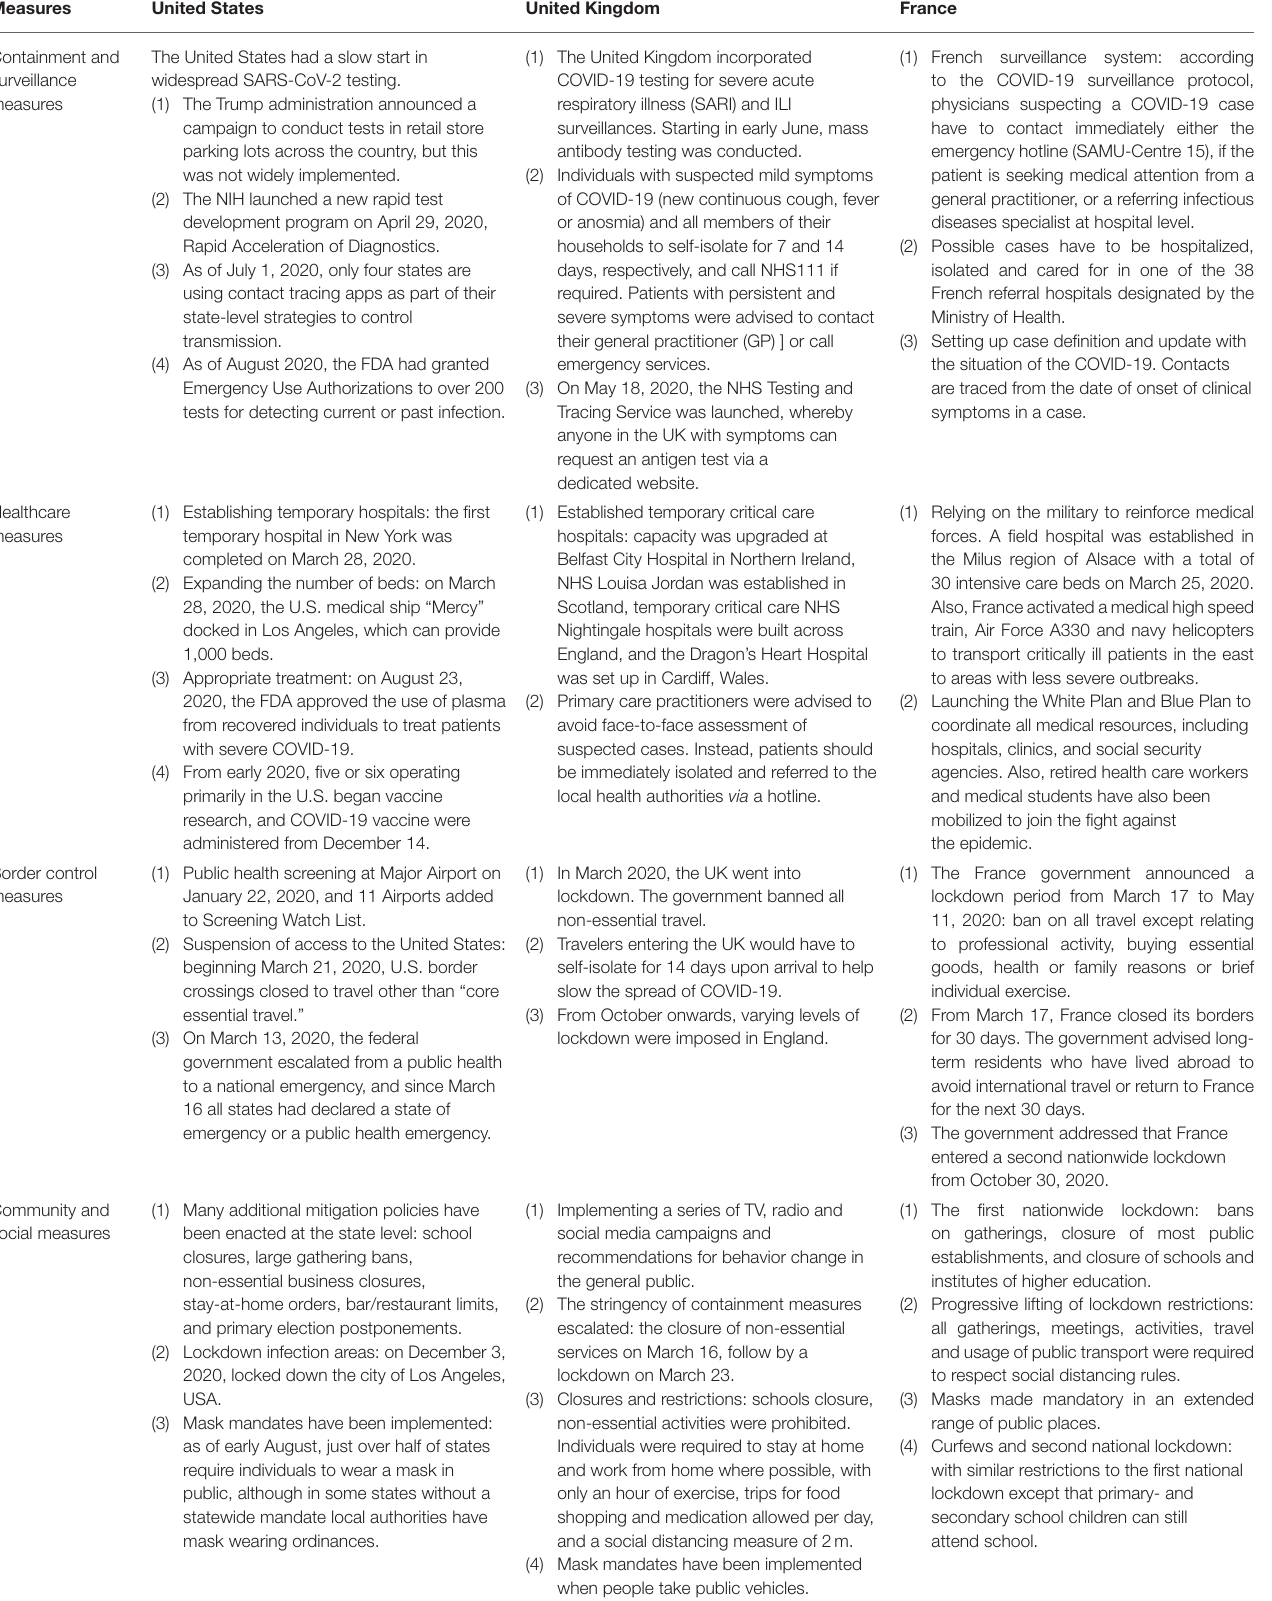
TABLE 2 | The major measures taken for COVID-19 in the United States, the United Kingdom, and France.